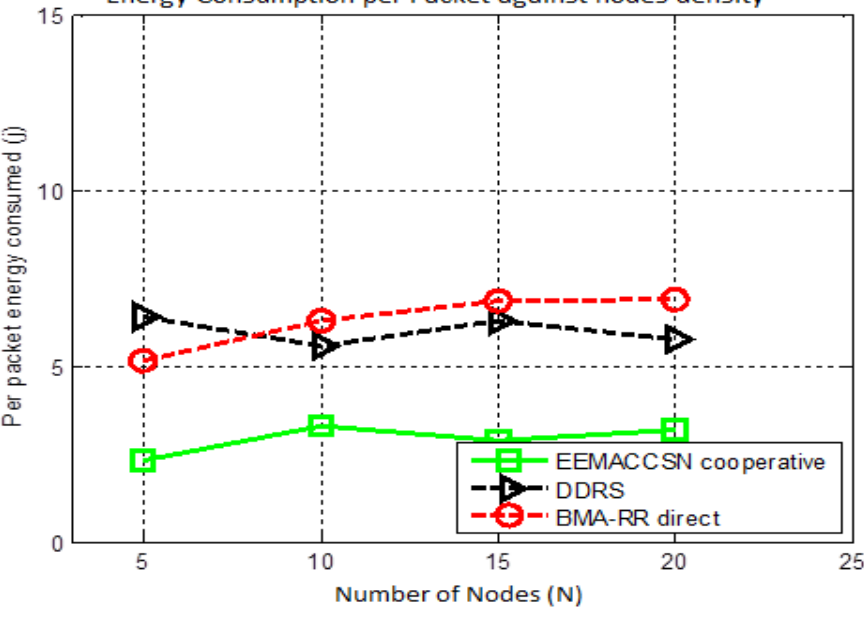
Figure 18. Energy performance vs. number of nodes